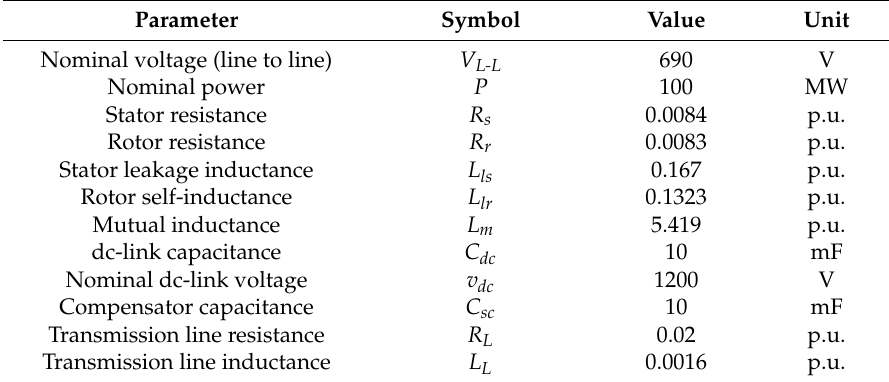
Table A1. System